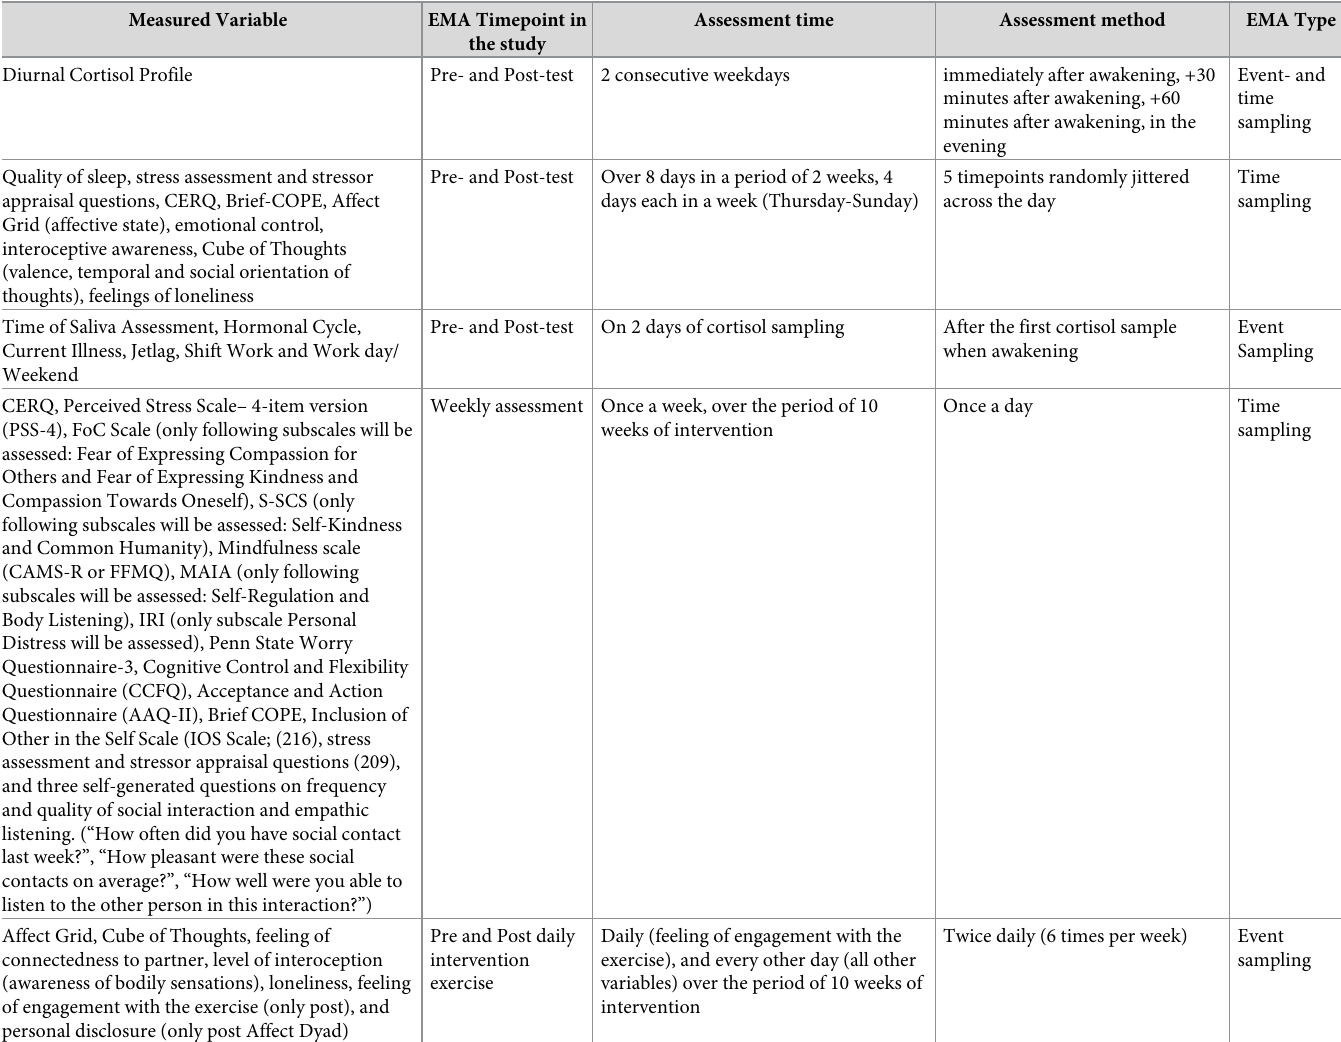
Table 1. An overview of all the different ecological momentary assessment (EMA) measures in the study, and the time and method of assessment. Measured